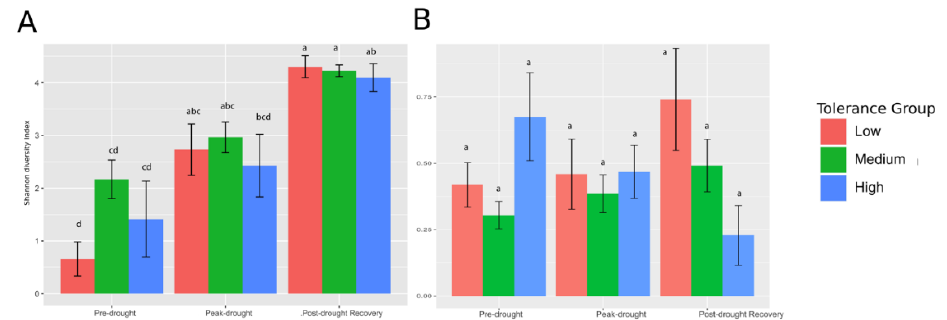
Figure 2. Shannon Diversity of Bacterial and Fungal Communities. Histograms of mean Shannon Diversity Indices at pre-drought, peak drought, and post-drought recovery stages for ( A ) bacteria and ( B ) fungi. Coloring denotes drought tolerance groups ‘Low’ (Red), ‘Medium’ (Green), and ‘High’ (Blue). Connecting letters denote significant difference at alpha-level 0.05 and are unique to each ( A ) and ( B ).